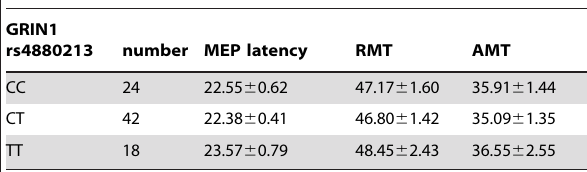
Table 3. Mean RMT, AMT, and MEP latency were not significantly different among CC, CT, and TT subjects of the rs4880213